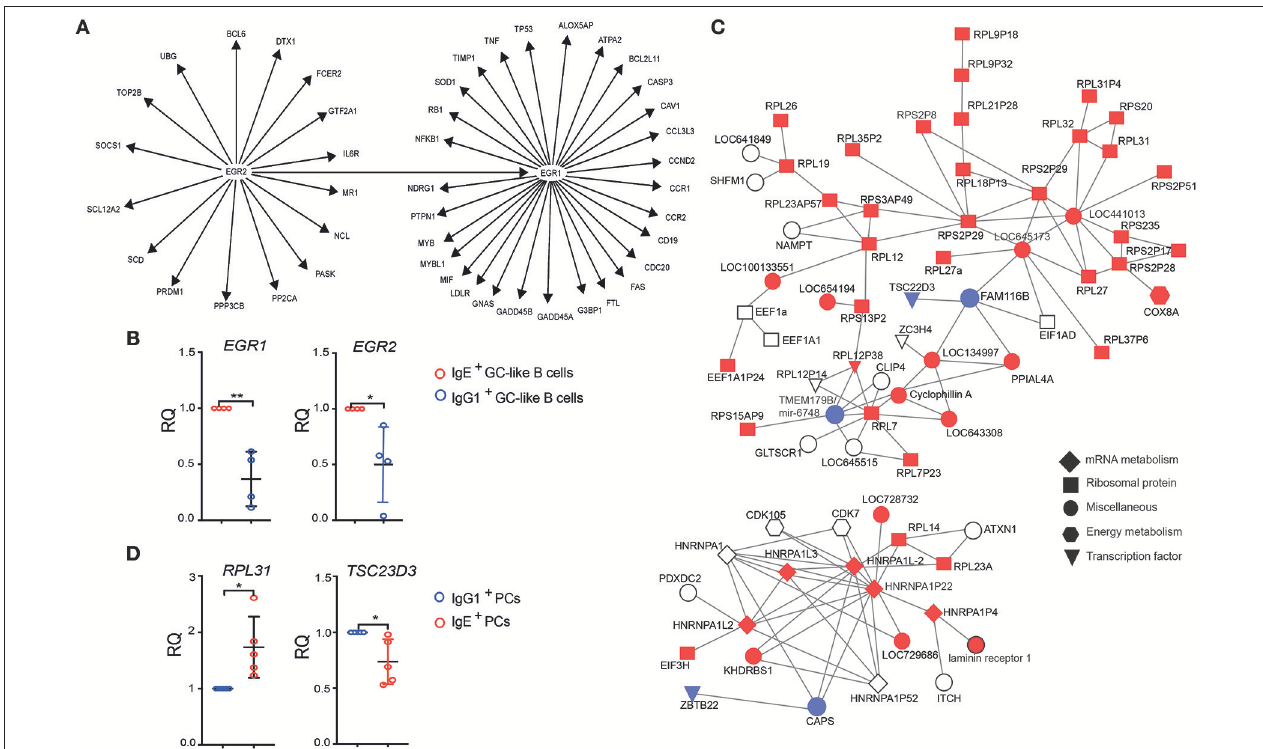
FIGURE 4 | Identification of gene interaction and co-expression networks associated with IgE + PC differentiation. (A) IPA was performed on genes that were differentially expressed between IgE + and IgG1 + cells ( > 1.5-fold and P < 0.05). The gene network was identified based on the literature contained in the IPA knowledge database. Target genes of the EGR1 and EGR2, shown in the figure, were found to be differentially expressed by more than 1.5-fold ( P < 0.05) either in IgE + and IgG1 + GC-like B cells compared to PBs or PCs or in IgE + cells compared to IgG1 + cells along their PC differentiation pathway. (B) RT-PCR validation of EGR1 and EGR2 expression in IgE + and IgG1 + GC-like B cells. Data represent the mean + /– SD of the relative quantification (RQ). Statistical analysis was performed using the t -test with Welch’s correction (* P < 0.05, ** P < 0.01). (C) Identification of a module of highly correlated genes, by WGCNA analysis encoding a large number of ribosomal proteins, that is enriched in IgE + PCs. In total this network contains 547 genes, however, to improve network visibility only those with a weight above 0.075 are shown. This de-novo co-expression network was negatively correlated with the IgG1 + PCs (correlation coefficient − 0.65, p = 0.003). The genes up-regulated (red) or down-regulated (blue) by more than 1.3-fold in IgE + PCs compared to IgG1 + PCs, whereas genes with < 1.3-fold difference are shown as uncolored. The shape of each node reflects the biological function of each gene, as determined by GO analysis. More detailed information about the top candidate genes displayed in the network can be found in the Supplementary Table 4 . (D) RT-PCR validation of RPL31, which is up-regulated, and TSC23D3 that is down-regulated in IgE + and IgG1 + PCs. Data represent the mean + /– SD of the relative quantification (RQ). Statistical analysis was performed using the unpaired t -test with Welch’s correction (* P < 0.05, ** P <